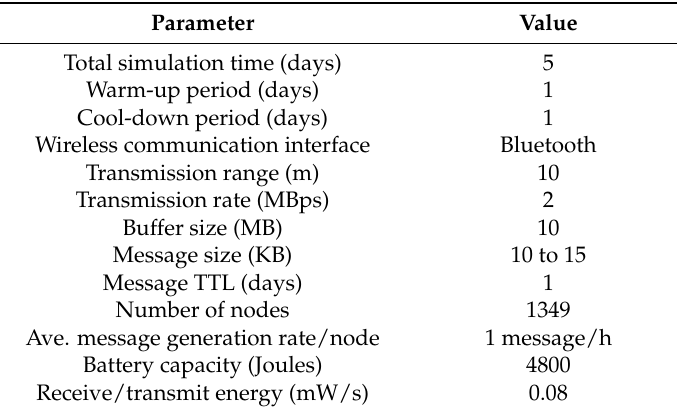
Table 4. Simulation parameters for the performance